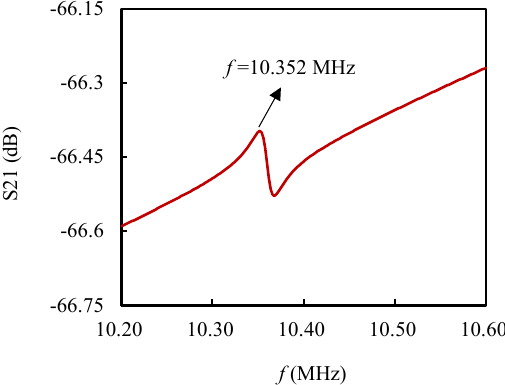
Figure 9. Simulation results of the equivalent circuit model.